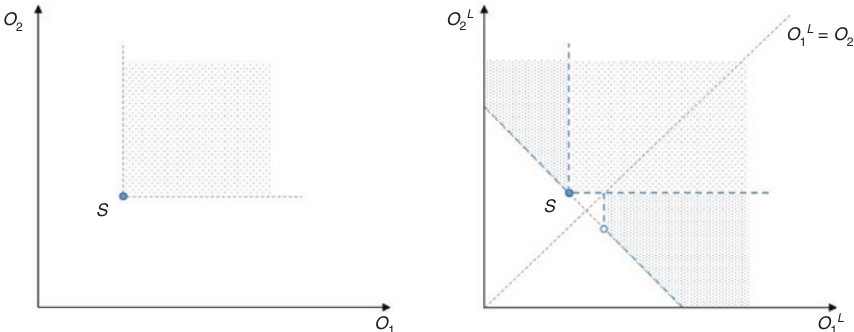
Figure 6: Pareto-dominated (Left) and Lorenz-dominated (Right)